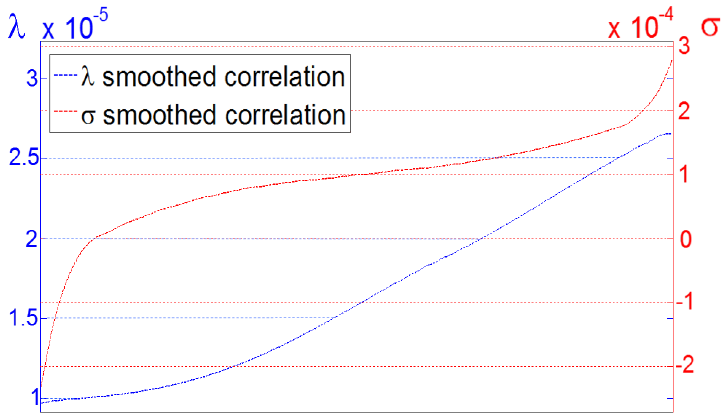
Figure 7. Example of evenly distributed Magnetic Field Aligned Mesh (MFAM) coordinates, λ and σ , using the Smoothing method used for initial contour selection.